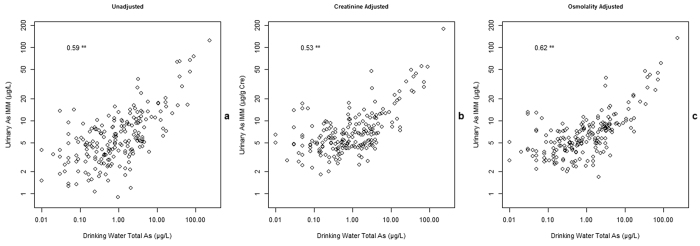
Comparison of alternative U-AsIMM adjustment methods.The comparison between unadjusted results (a), creatinine adjusted results (b) and osmolality adjusted results (c). The Spearman correlation is stronger in osmolality adjusted results than both alternatives.